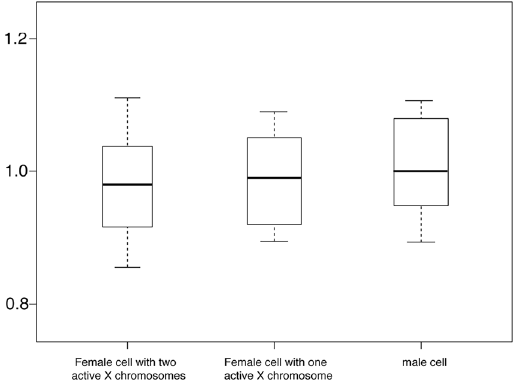
Figure 5. There is a similar X: A expression ratio whether there are one or two active X chromosomes present in cells. We divided all the cells in mouse we examined into three groups (female with two active X chromosomes, female with one active X chromosomes and male), the X: A expression ratio for all the three groups are close to 1 whether there are one or two active X chromosomes present in cells (P > 0.05, by Student’s t-test). The X: A ratio for each group is significant close to 1 compare to 0.5 (student’s t-test, p < 0.001). The percentiles in all boxplots are 0.05, 0.25, 0.5, 0.75 and